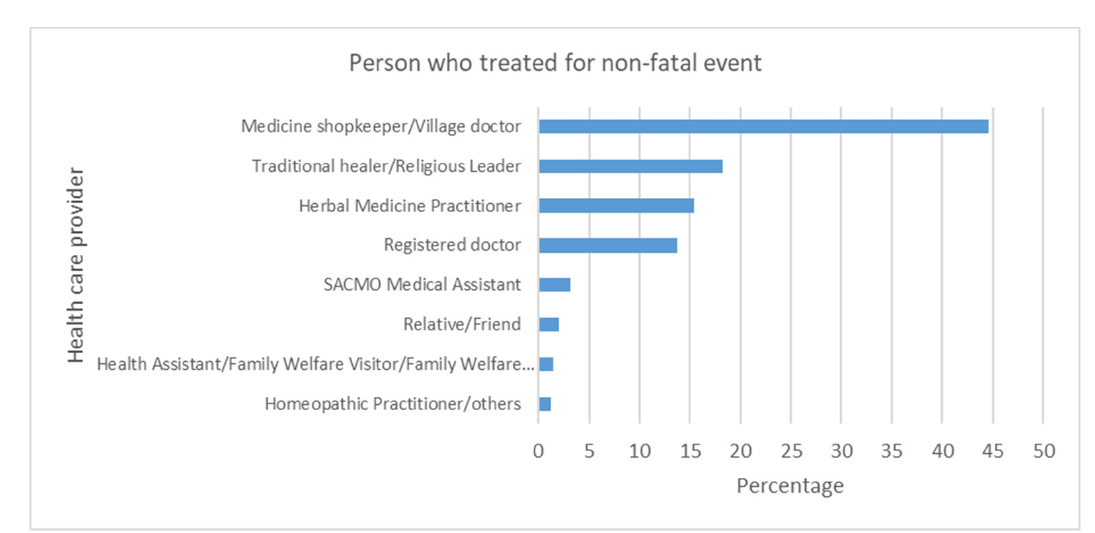
Figure 1. Personnel attending person with non-fatal drowning event.